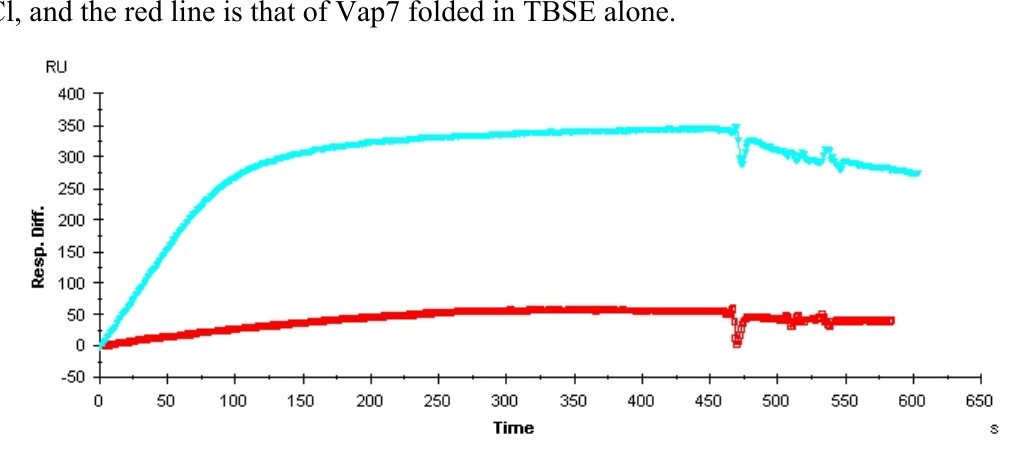
Figure 3. Change in the SPR spectrum of Vap7 depending to presence of KCl. VEGF (10 pmol) was immobilized on a sensor chip according to the manufacturer’s protocol. Vap7 was diluted to 10 µM with TBSE or TBSE–KCl and then folded by heating. The analyte used for SPR was diluted to 500 nM with the same buffer that was used for folding.The light blue line is the spectrum of Vap7 folded in TBSE containing 50 mM of KCl, and the red line is that of Vap7 folded in TBSE alone.